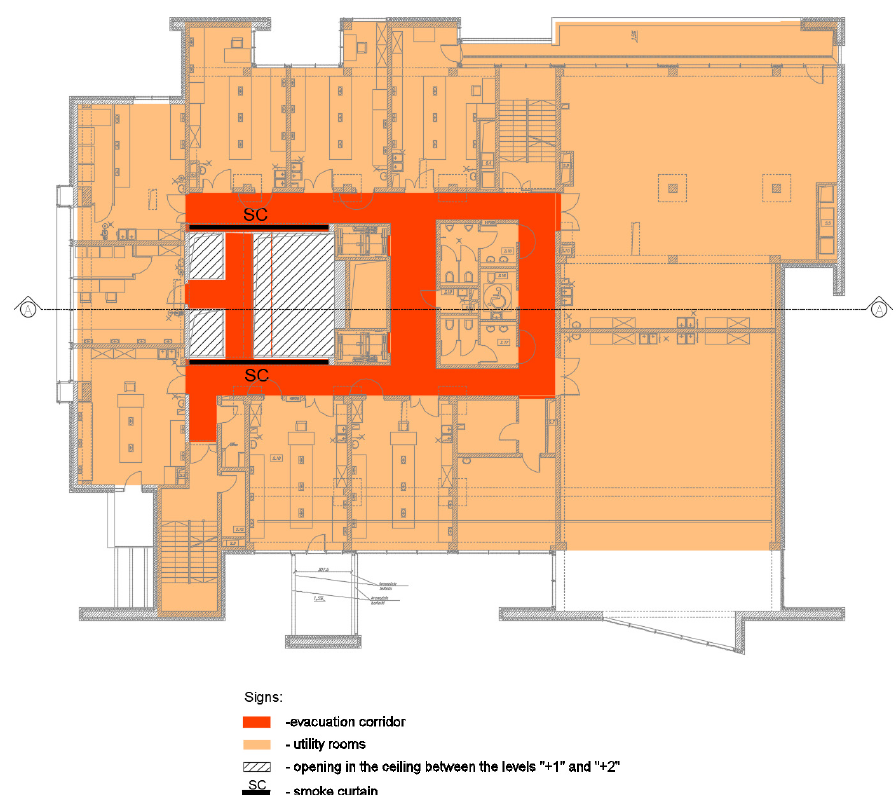
Figure 8. Atrium—Level 1.